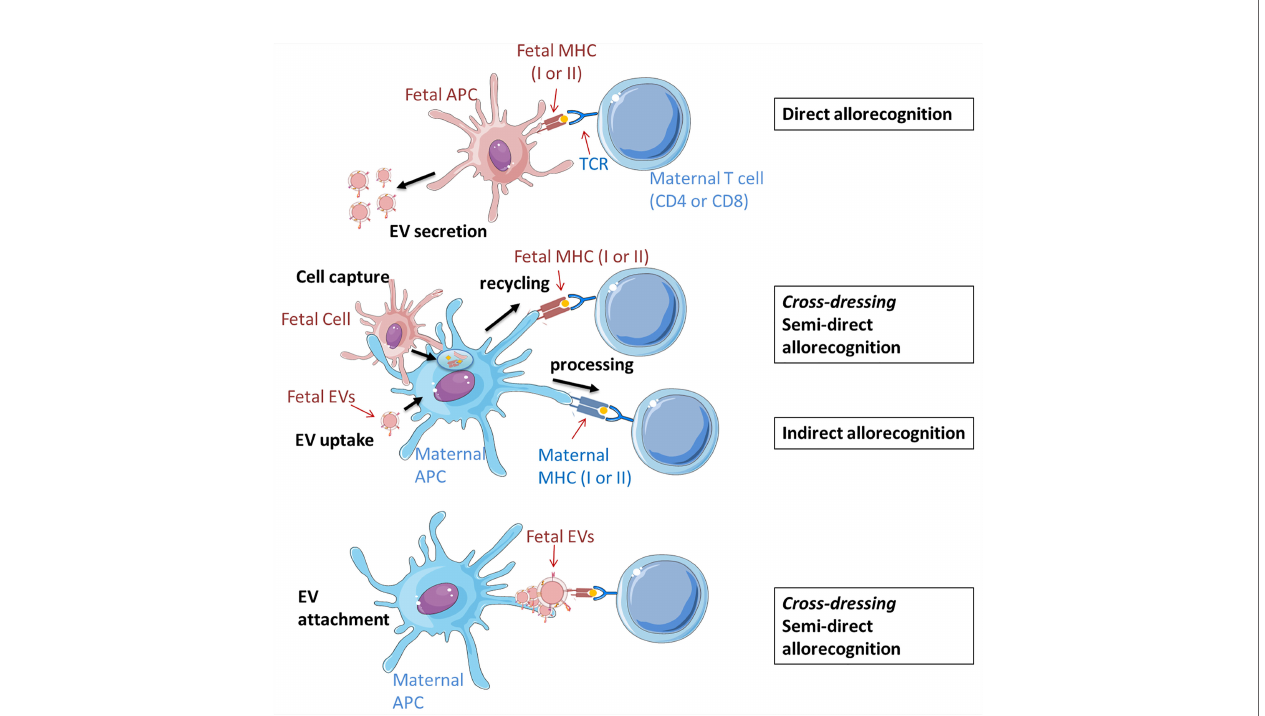
FIGURE 2 | Potential scenarios of EV involvement in the fetal allorecognition by maternal T cells. Maternal cells are shown in blue and fetal cells and EVs are shown in red. Up: Direct pathway. Fetal APCs, which secrete EVs to the intercellular space, present peptides (auto- or alloantigens) via MHC (I or II) molecules to immunocompetent maternal T cells. Middle: In the semi-direct pathway, fetal allogeneic MHC molecules (I or II) are acquired via capture and uptake of fetal cells (entire or only their cell membrane) or their secreted EVs, and then recycled and expressed on the maternal APC surface. APC can present antigens bound to fetal MHC molecules to maternal T cell receptors. The indirect pathway implies the processing of fetal proteins from EVs or cells and the presentation of deriving peptides by maternal MHC II complexes to T maternal cells. Down: Fetal-derived EVs cross-decorate maternal APCs with intact MHC-peptide complexes that can be recognized by T cells similar to the semi-direct pathway. All displayed processes involve co-stimulatory interactions between APCs and T cells which are decisive for subsequent reactions, which may be tolerogenic, immunoregulatory or – stimulatory. The fi gure was drawn using pictures from 105 (http://smart.servier.com/) and was based on previous revisions (5,